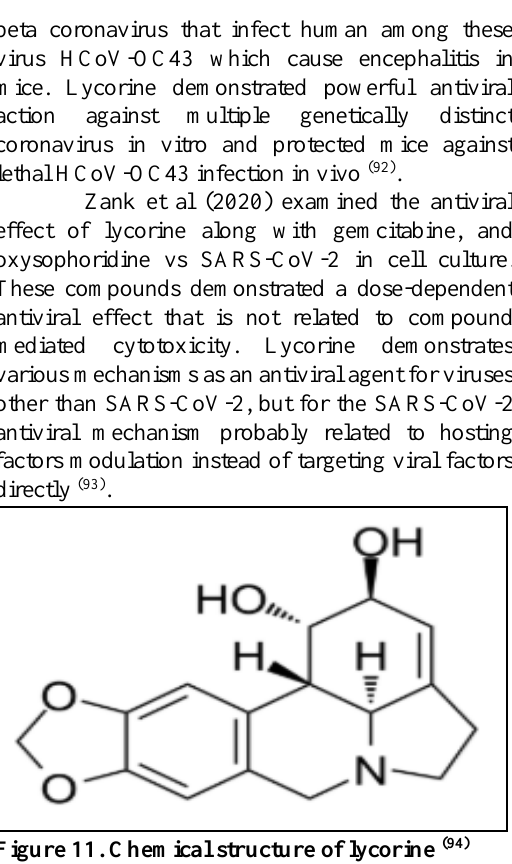
Figure 11. Chemical structure of lycorine (94)